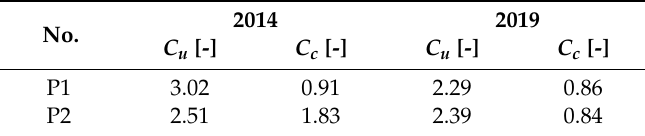
Table 2. Debris parameters.